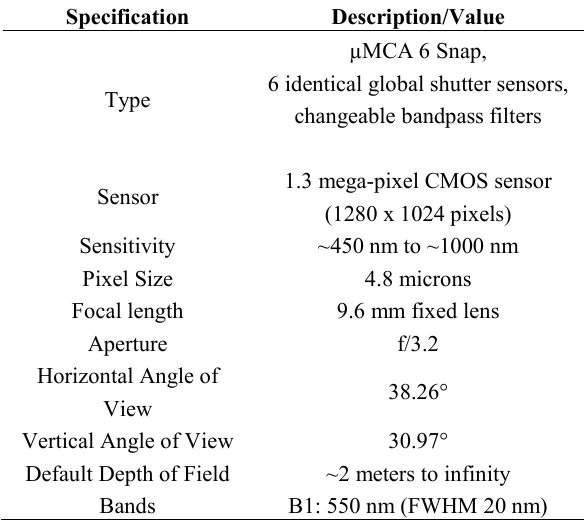
Figure 1. Multiple camera array Tetracam μ-MCA Snap 6.